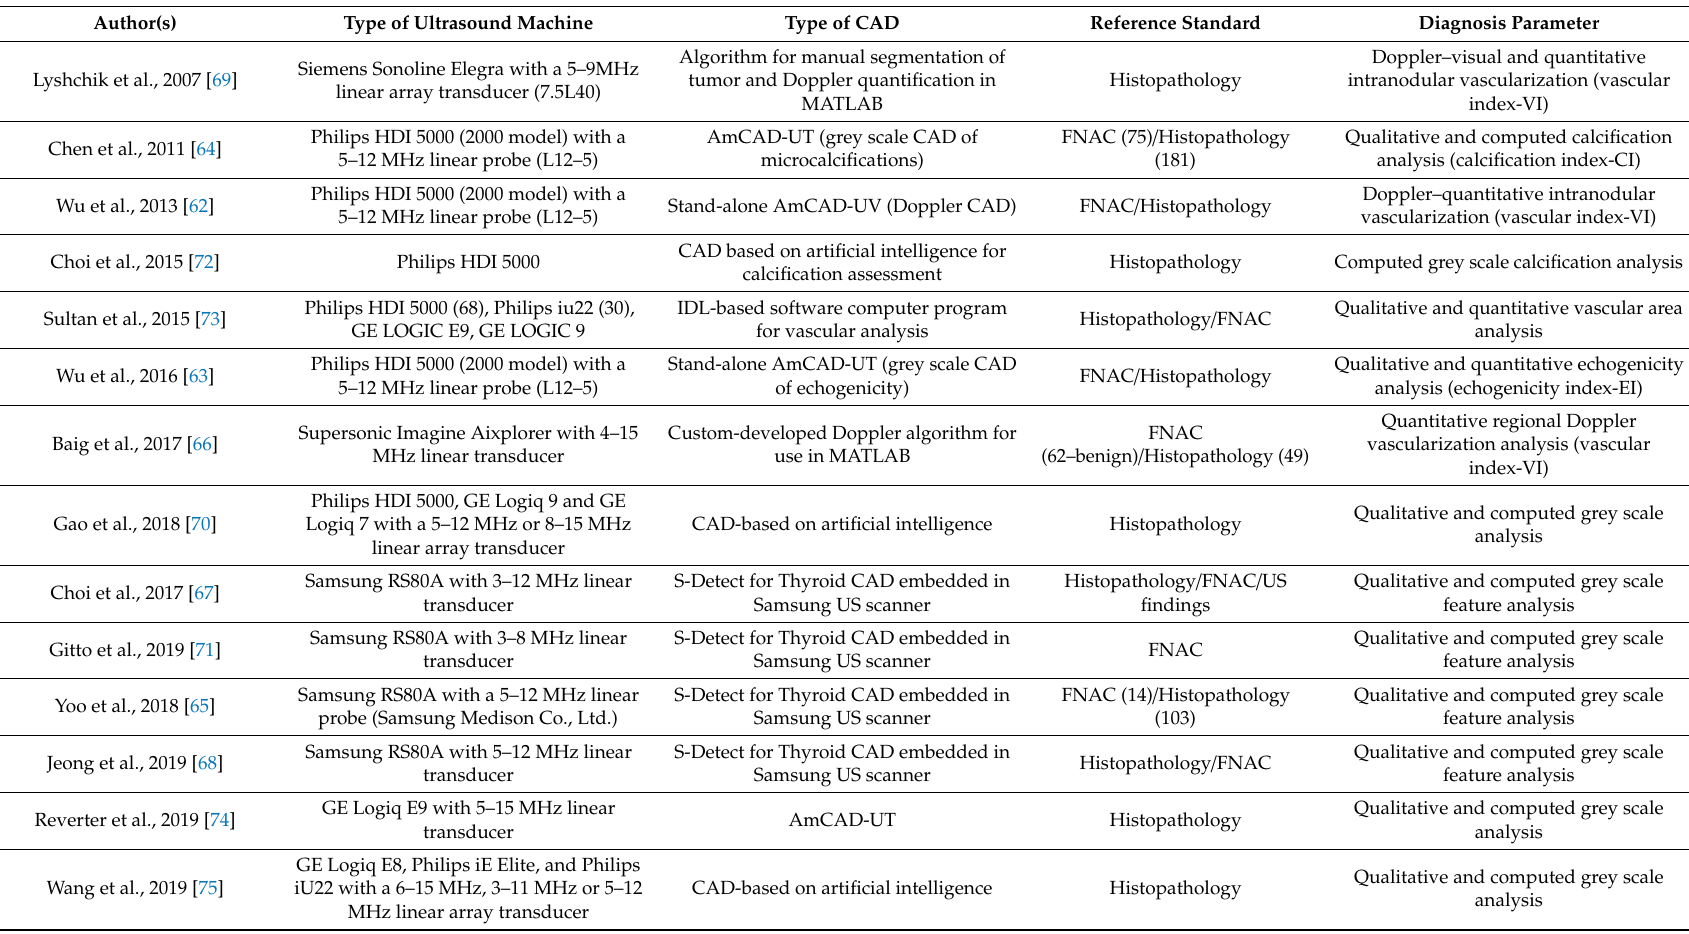
Table 2. Main features of the diagnostic tools used in the included